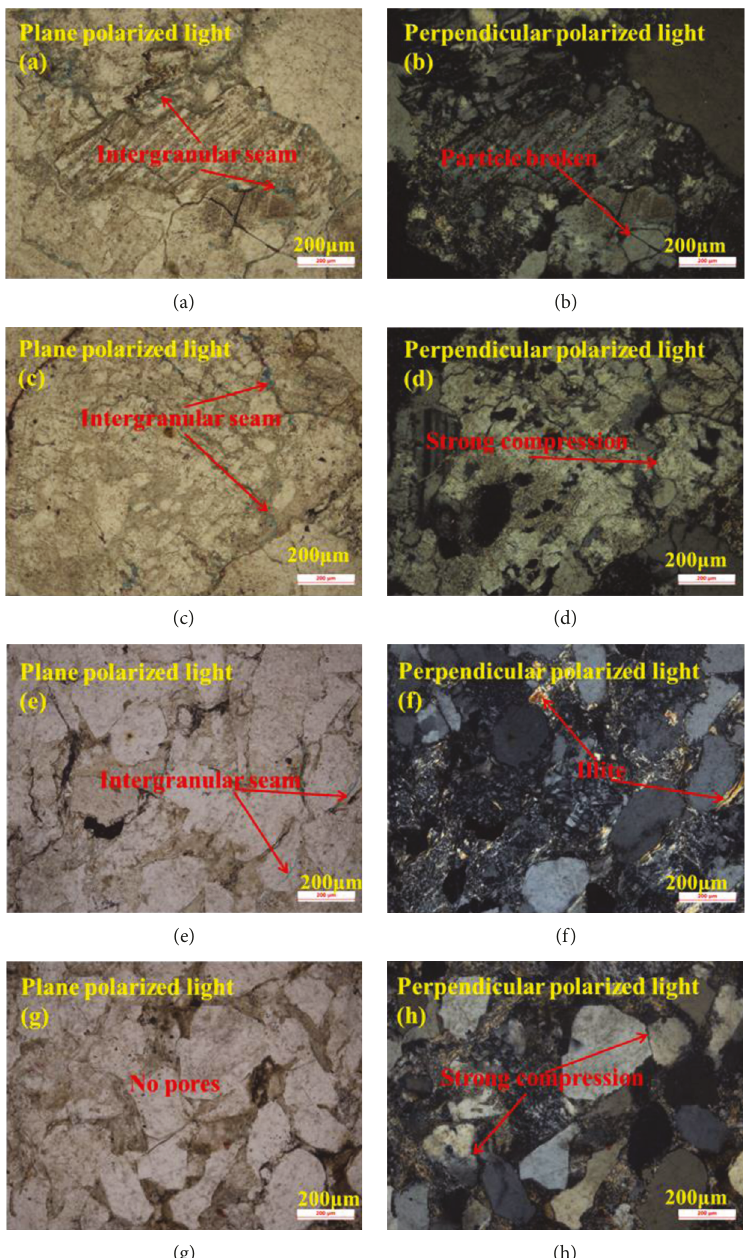
Figure 7: The casting thin section: (a) – (e) belong to M72-5 and (f) – (h) belong to S123-1. The left picture and the right picture belong to the same